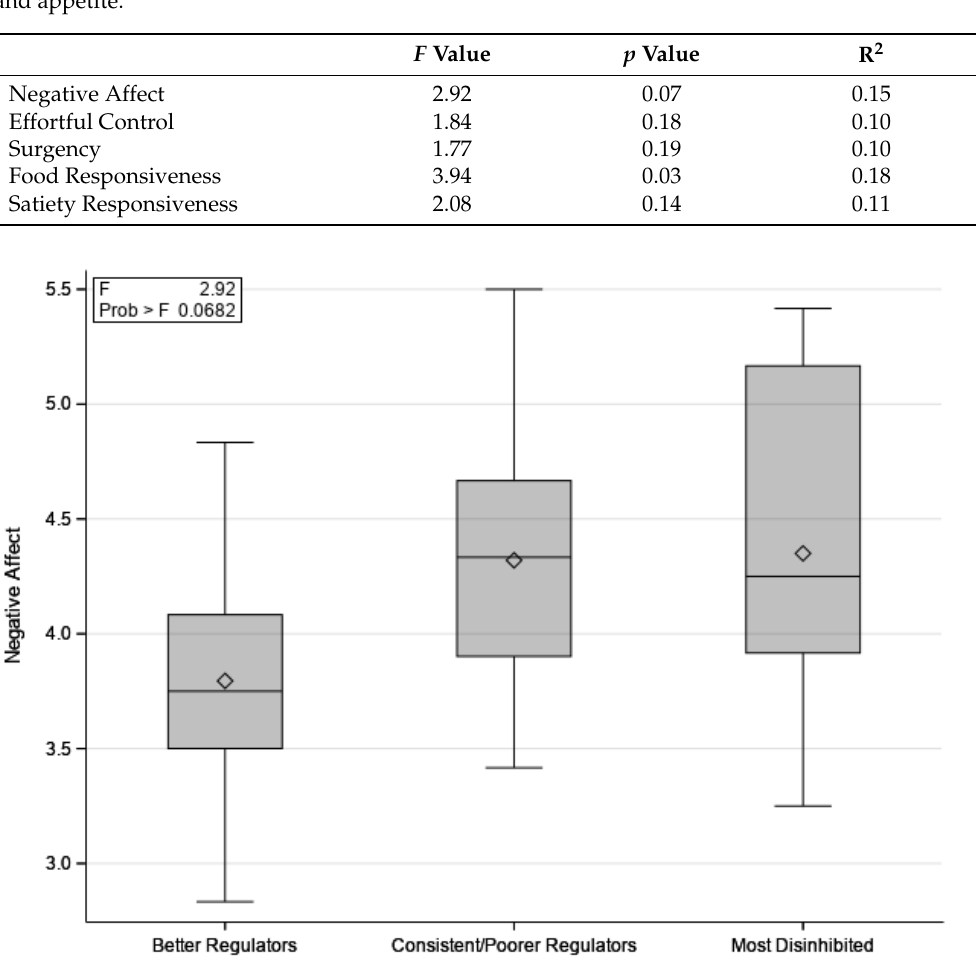
Figure 3. Means of children’s negative affect for “Better Regulators” ( n = 15), “Consistent/Poorer Regulators” ( n = 12), and “Most Disinhibited” ( n = 11) groups.